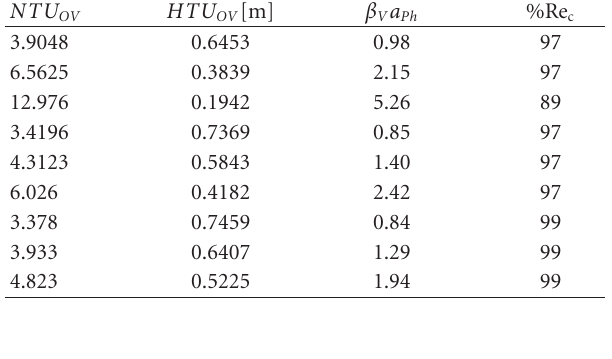
Table 3: Mass transfer results.